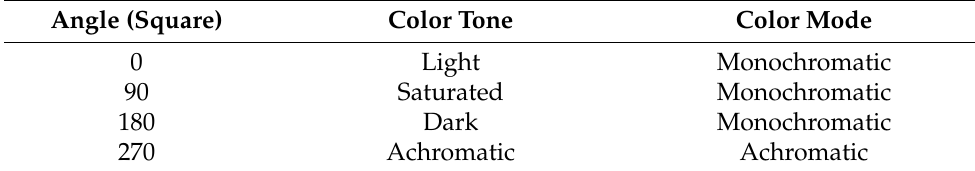
Table 1. Colors tones or color mode according to the angle of the square disk.